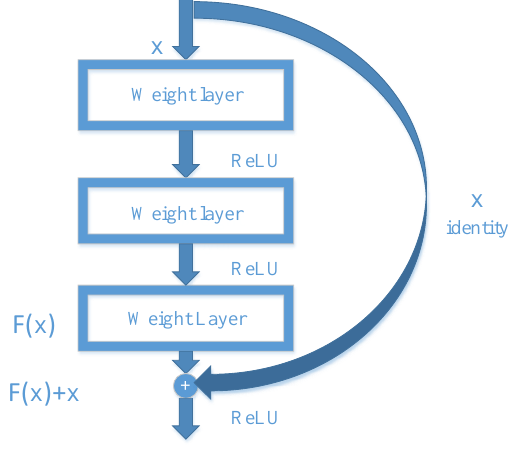
Figure 7. The building block